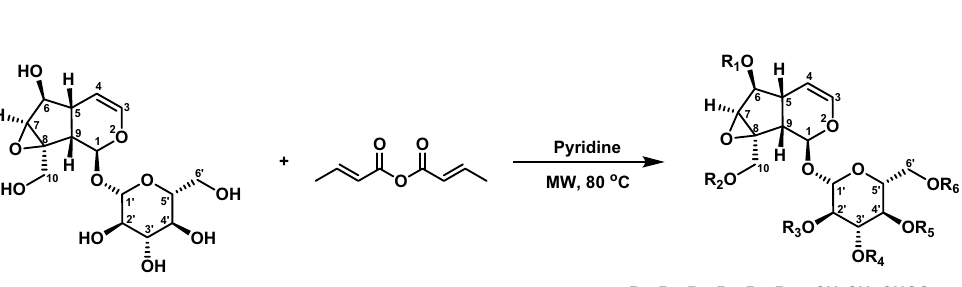
Figure 3. RMSD analysis of 40 ns molecular dynamic track of the system.